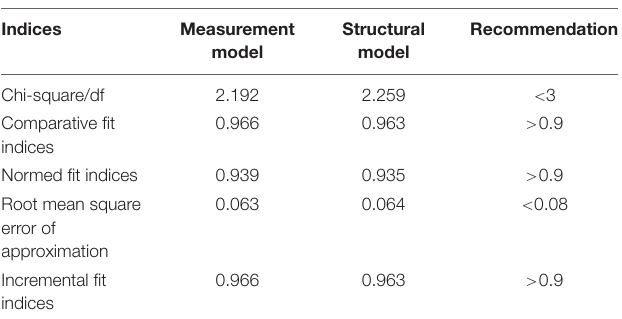
TABLE 3 | Fit indices.